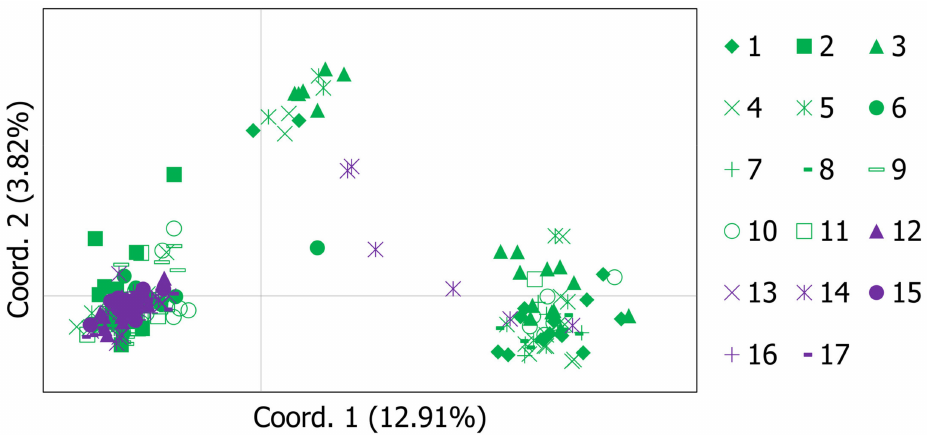
Figure 2. Results of the principal coordinate analysis (PCoA) for eastern grey populations inside (green) and outside (violet) of the Mourachan Conservation Property (see Table 1 and Figure 1 for details on location IDs). The percentage of the total variation in the dataset explained by each principal coordinate is given in